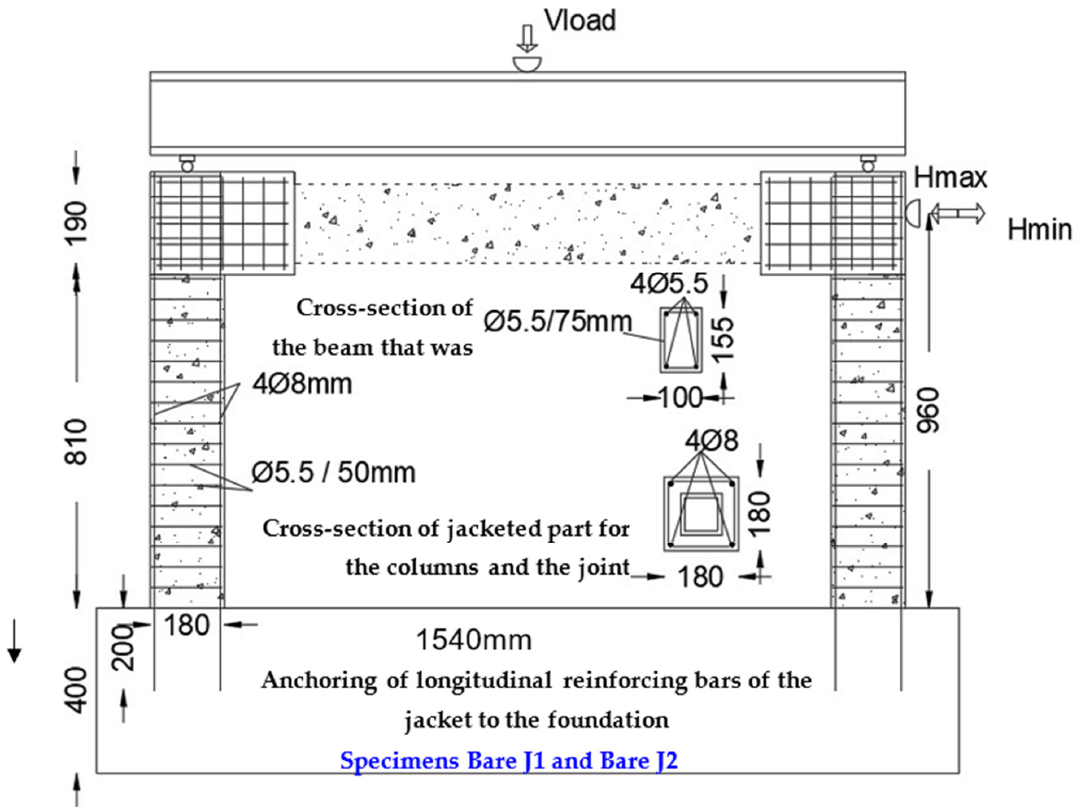
Figure 10. Specimens Bare J1 (Bare Jacket1) and Bare J2 (Bare